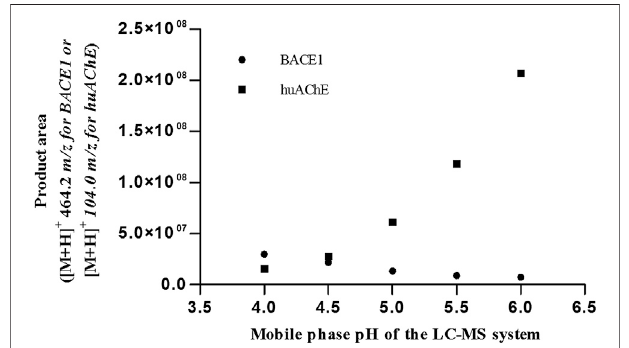
FIGURE 1 | Activities of huAChE-ICER and BACE1-ICER in individual enzymatic system assays as a function of the pH of the mobile phase.